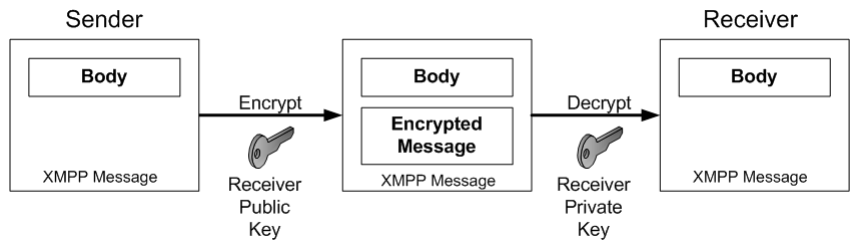
Figure 7. XMPP message encryption in